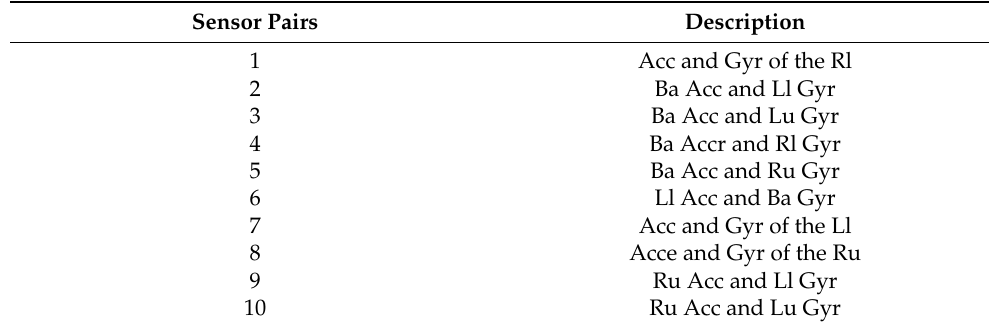
Table 1. Sensor pairs used to derive the Opportunity datasets. Ba = Back, Rl = Right lower arm, Ru = Right upper arm, Lu = Left upper arm, and Ll=Left lower